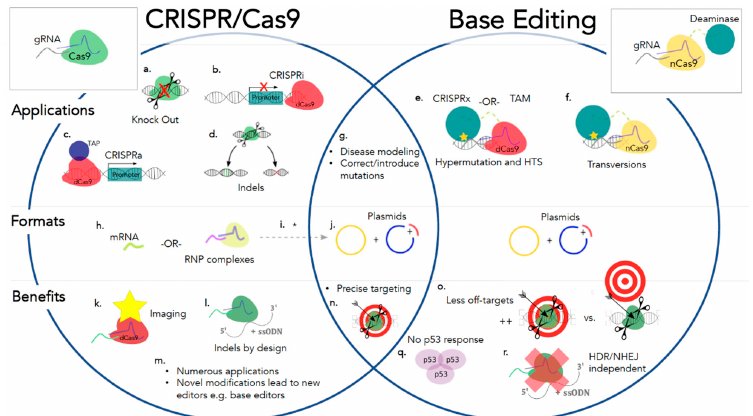
Figure 2. A comparison of the CRISPR / Cas9 and base editing systems on the basis of applications, formats, and benefits. Applications for CRISPR / Cas9 and